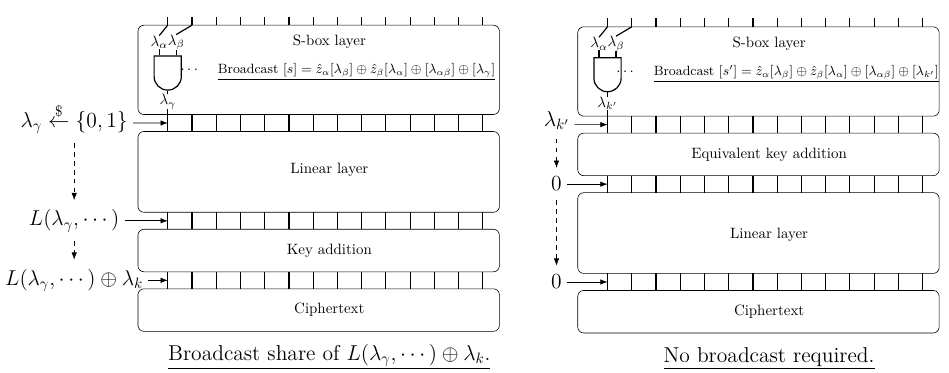
Figure 4: Changes to output phase of MPC